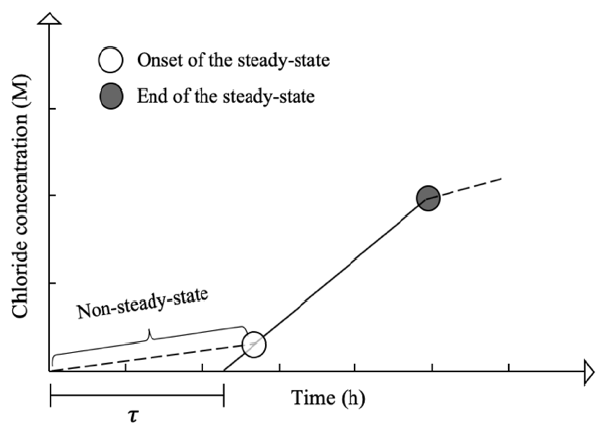
Figure 6. Scheme for determining the time-lag ( τ ), the steady-state, and non-steady-state (Adapted from Ribeiro et al. [30]).